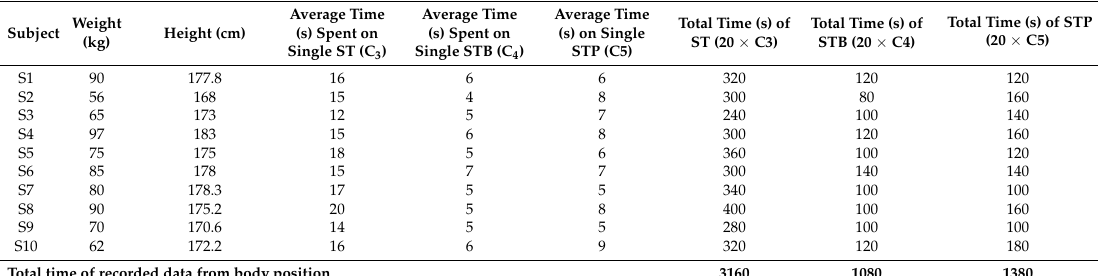
Table 2. Brief summary of the data collection and details about the subjects. C3, C4, and C5 are columns three, four, and five. S1 to S8 are Males; S9 and S10 are